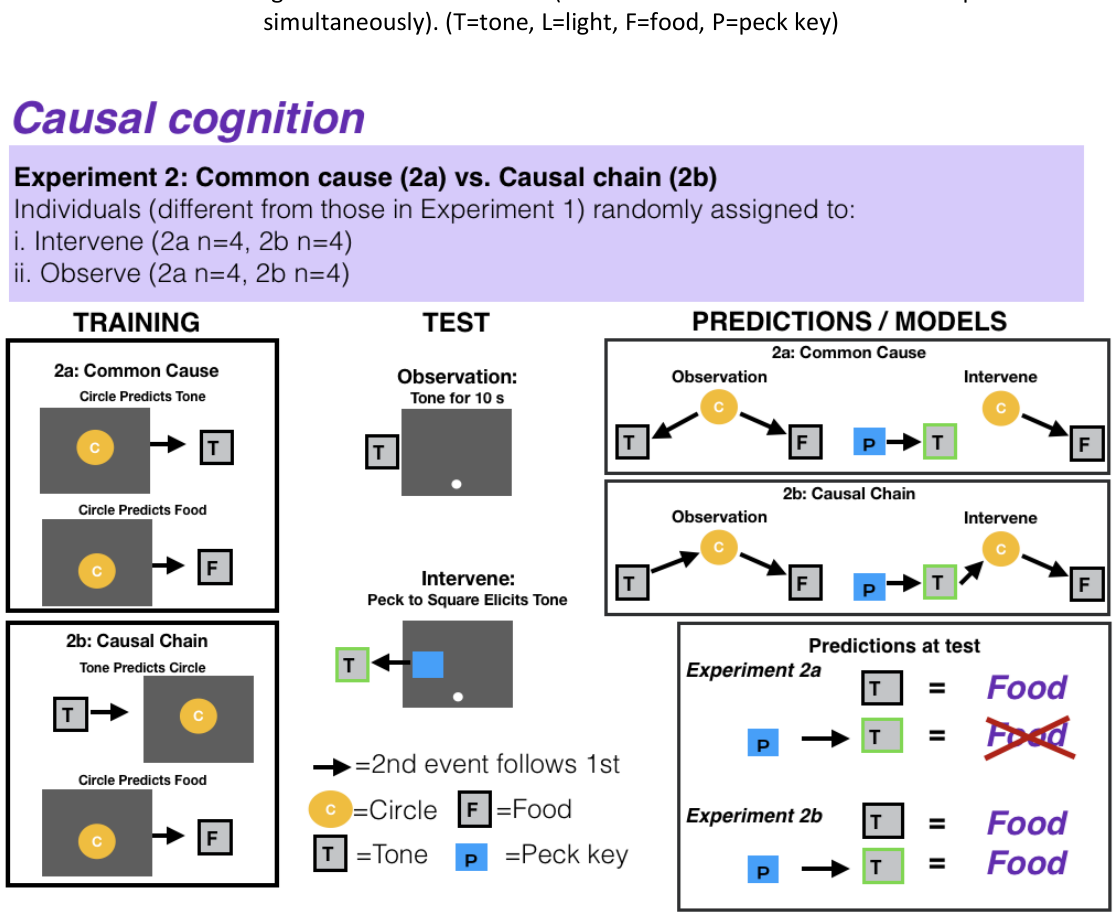
Figure 7. Planned design for experiment 2: Test figures adapted from Blaisdell et al. (2006).